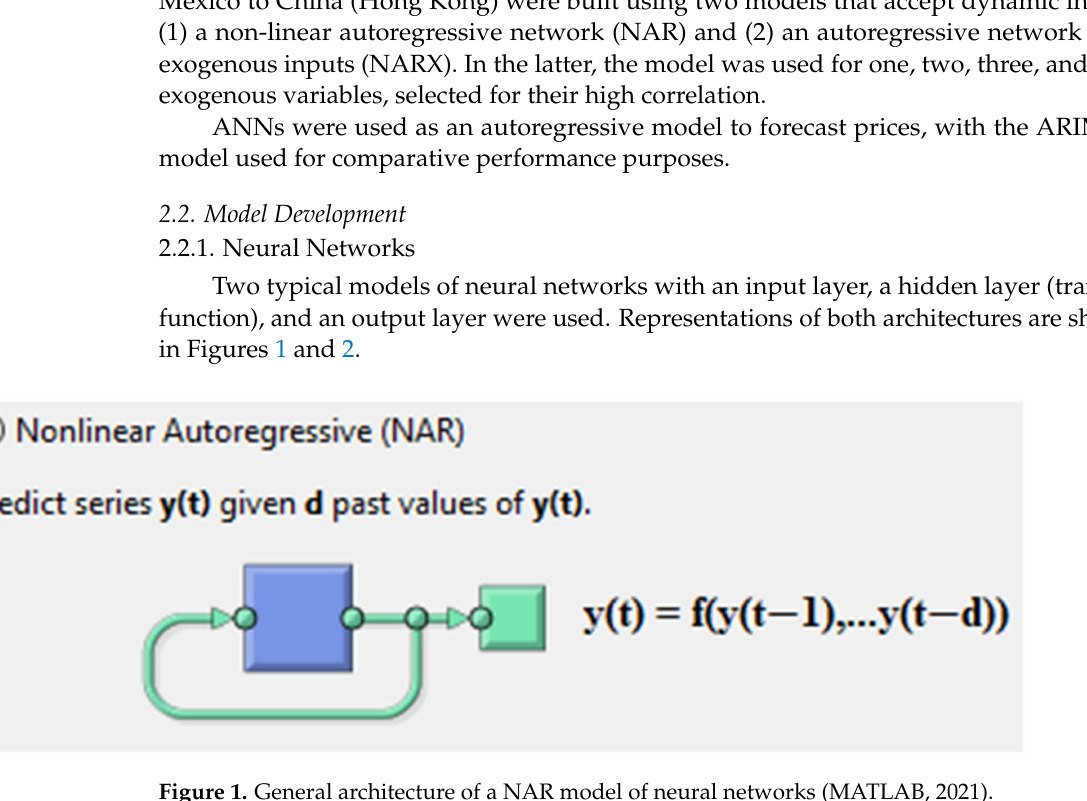
Figure 1. General architecture of a NAR model of neural networks (MATLAB, 2021).